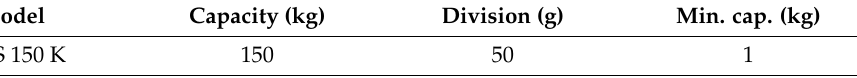
3 × 1.5 V AA battery. Low energy consumption, designed for lengthening the battery life (150 battery life). “Auto-off” function after the set time: 0, 5, 15, 30, and 60 min.